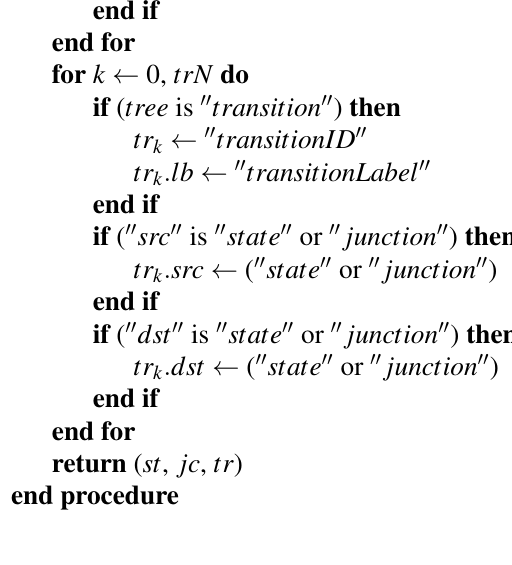
Fig. 3. XML to intermediate file